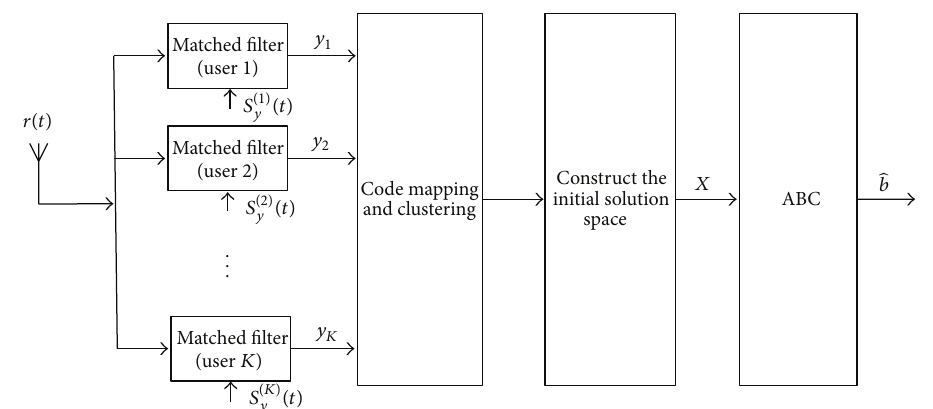
Figure 2: General schematic diagram of the SCM-ABC-MUD detector.